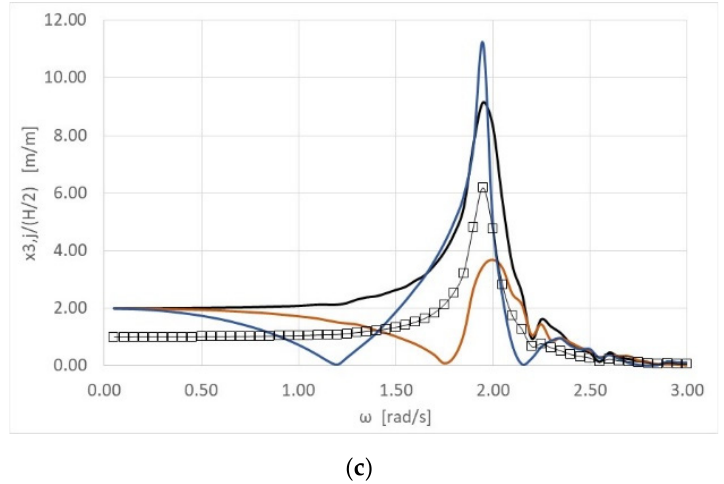
Figure 3. Dimensionless heave displacement of the 1st WEC, j = 1, of the parallel to the wall array, against ω , for three different examined distances from the vertical wall and three wave heading angles. Comparisons are made for the heave displacements of the same converter of the array without the presence of the breakwater: ( a ) θ = 0°; ( b ) θ = 45°; ( c ) θ = 60°.